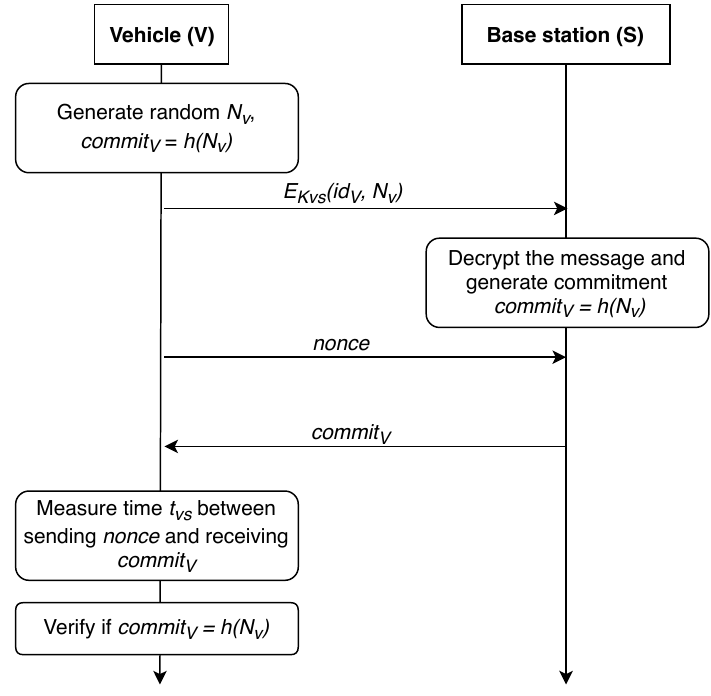
Figure 6. Distance-bounding protocol with base station